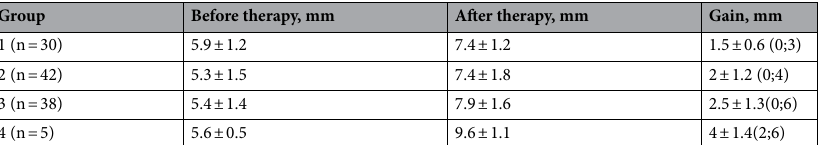
Table 2. Ultrasonography measurements of endometrial thickness before and after the therapy. The data are presented as mean ± SD (min;max).